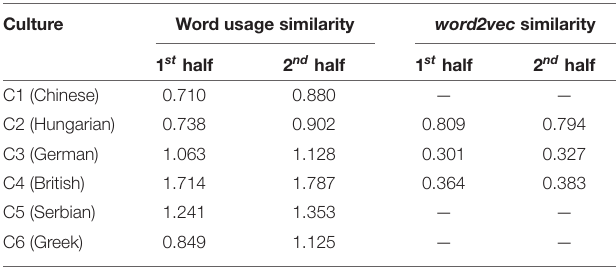
TABLE 4 | Evaluation of linguistic similarities between dyadic companions in the two halves of the video chat.